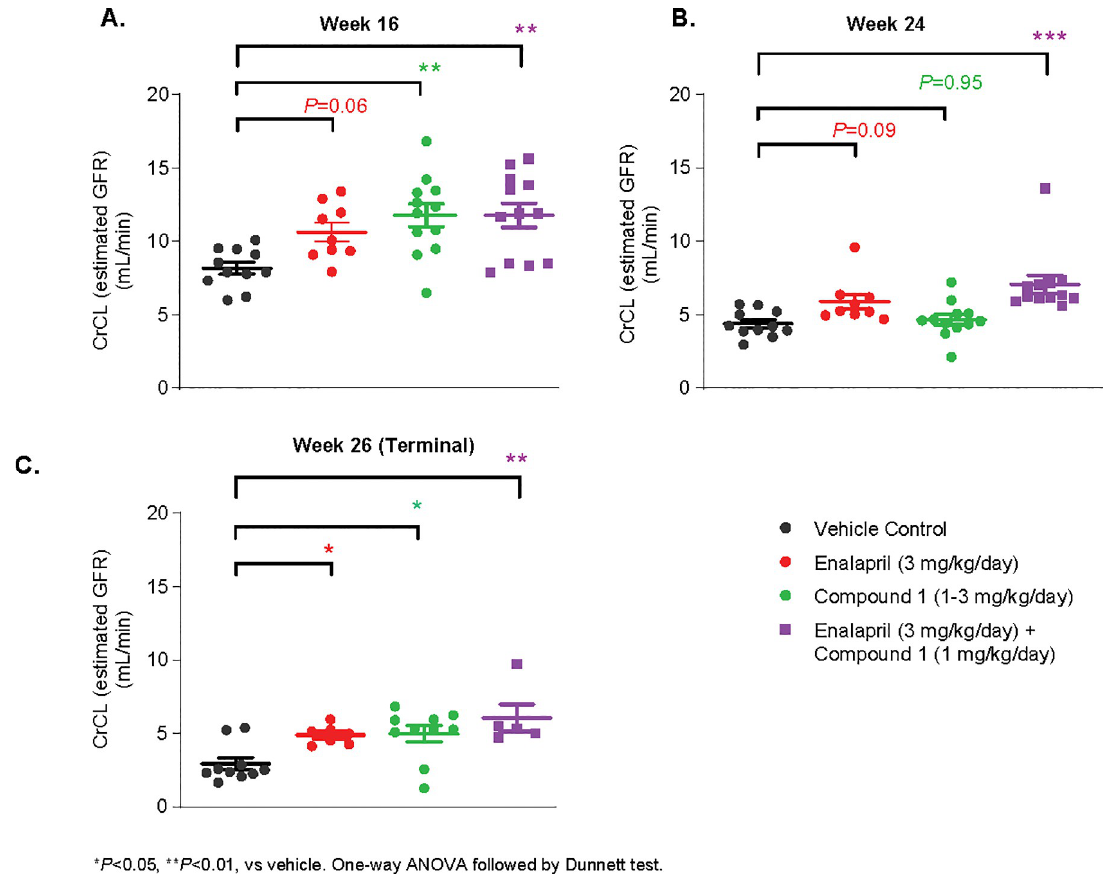
Fig 4. Chronic effects of Compound 1 on GFR in ZSF1 OB rats. GFR by creatinine clearance (CrCL) was improved by Enalapril, Compound 1 and combination at 16 weeks (A) and at (C) 26 weeks vs that of Vehicle control. � P < 0.05 vs Vehicle control. One-way ANOVA followed by Dunnett’s